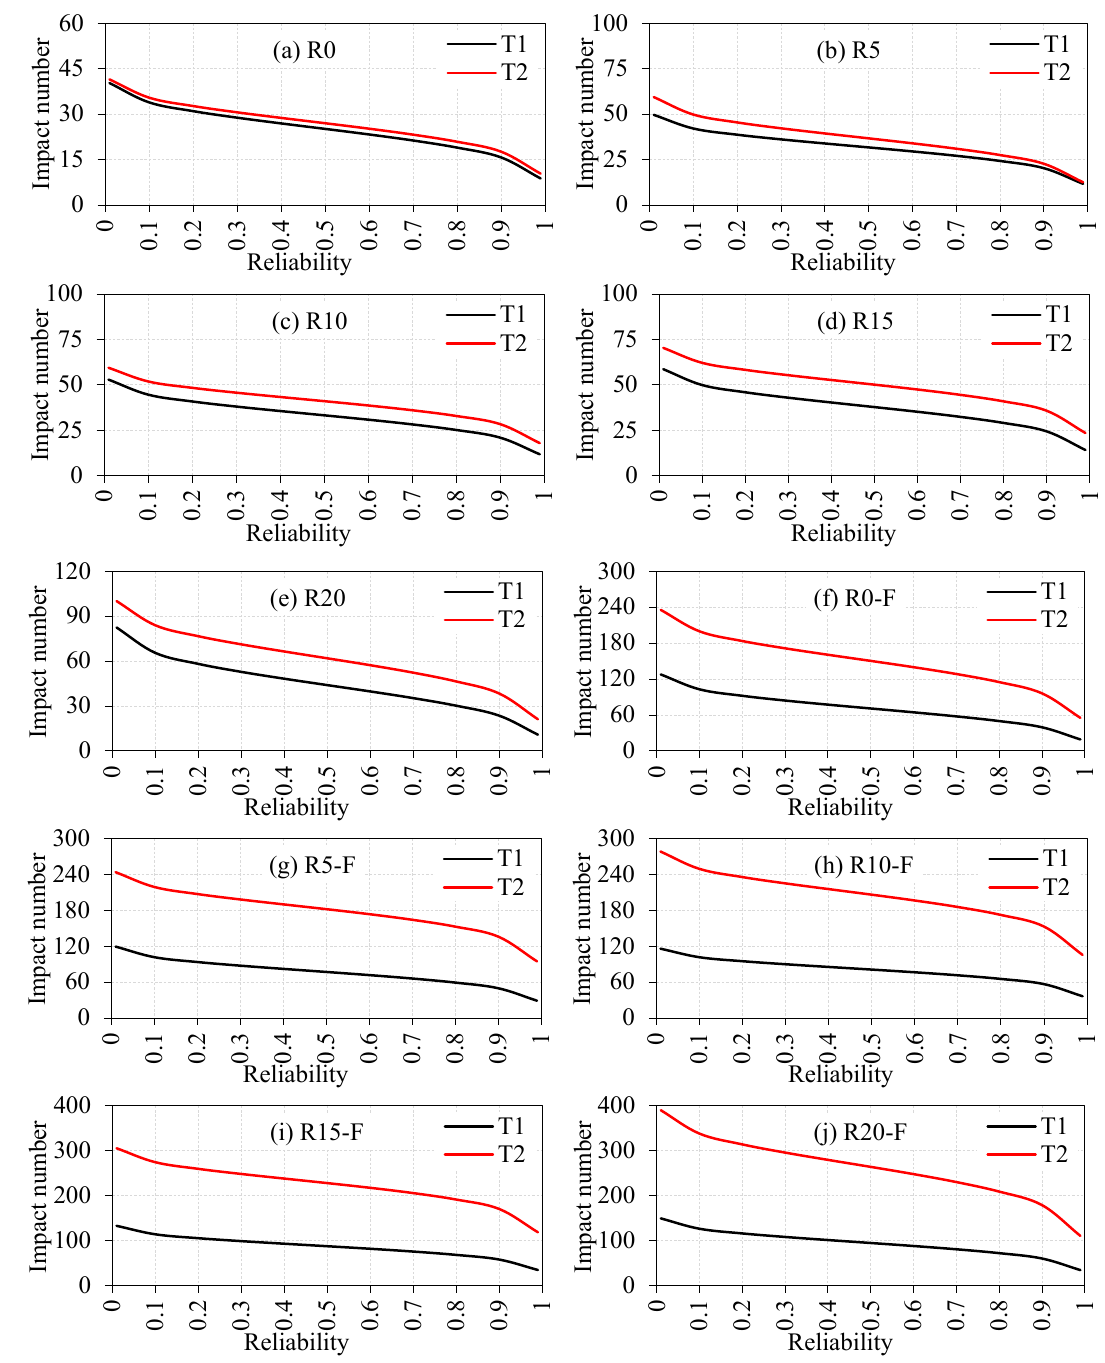
Figure 13. Impact strength in terms of reliability ( a ) R0, ( b ) R5, ( c ) R10, ( d ) R15, ( e ) R20, ( f ) R0-F, ( g ) R5-F, ( h ) R10-F, ( i ) R15-F and ( j ) R20-F.